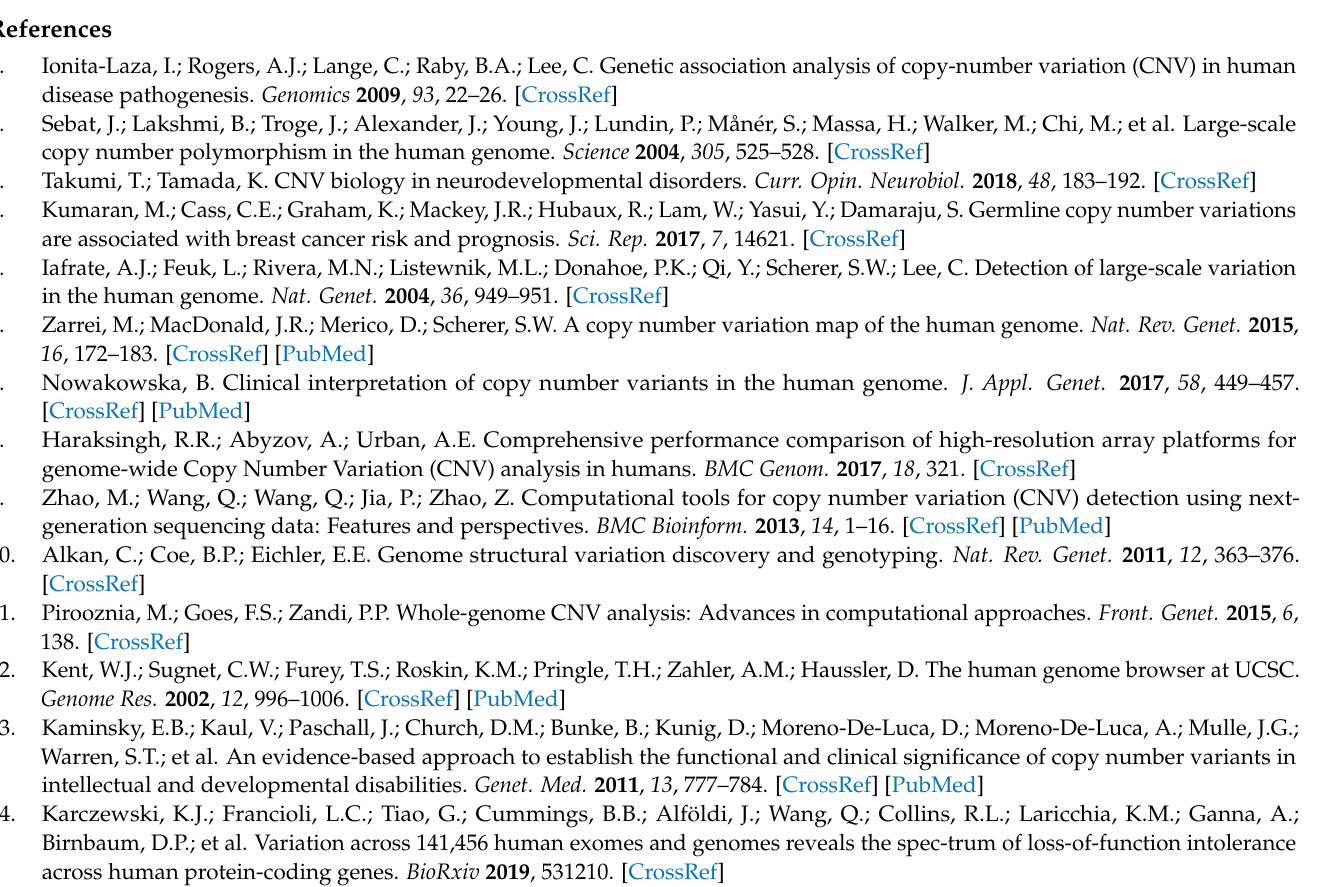
Table S3: assessment of tools’ accuracy identifying CNV breakends using twelve MLPA-confirmed CNVs of varying sizes, File S1: Detailed algorithms of SV calling